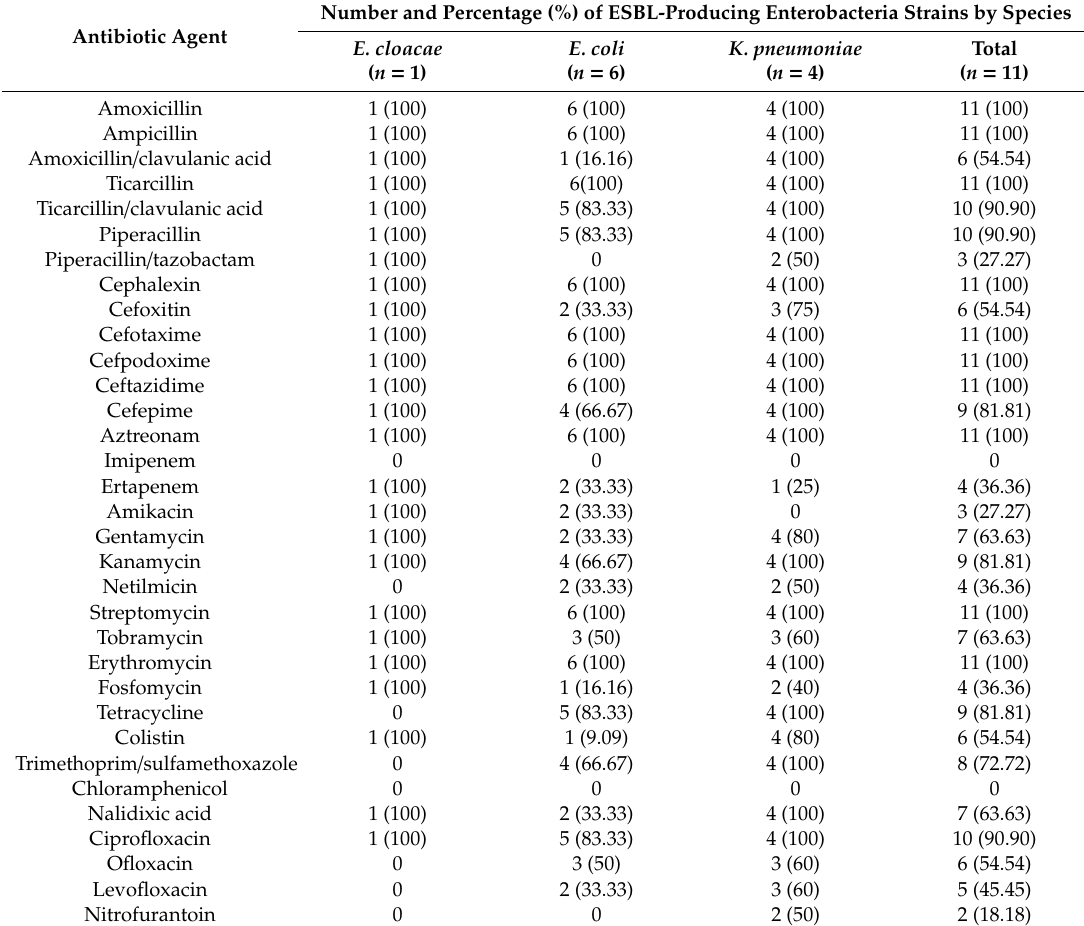
Table3. Prevalenceofantibioticresistanceinentericbacterialstrainscarryingresistanceforbeta-lactams. Antibiotic